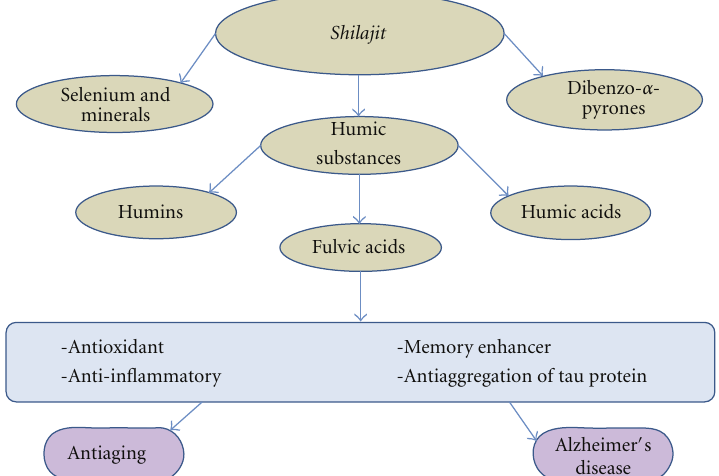
Figure 1: Shilajit , its main components, and potential uses based on properties of fulvic acid. This phytocomplex known as shilajit is mainly composed of humic substances. One of them, fulvic acid, is known by its properties such as antioxidant, anti-inflammatory, and memory enhancer. Novel investigations indicate that fulvic acid is an antiaggregation factor of tau protein in vitro [1], which projects fulvic acid as a potential anti-Alzheimer’s disease molecule. Table 1: Morphometric study of primary cultured rat hippocampal cells exposed to Shilajit and the Brain Up-10 formulae that